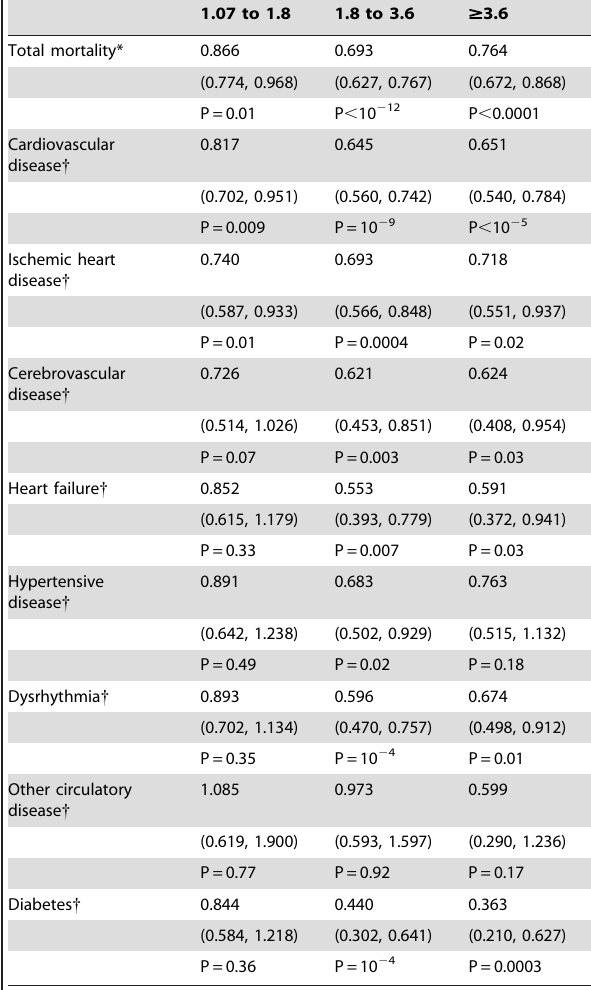
Table 9. Survival analyses of all related mortality, i.e., underlying or contributing causes of death vs. categories of walking energy